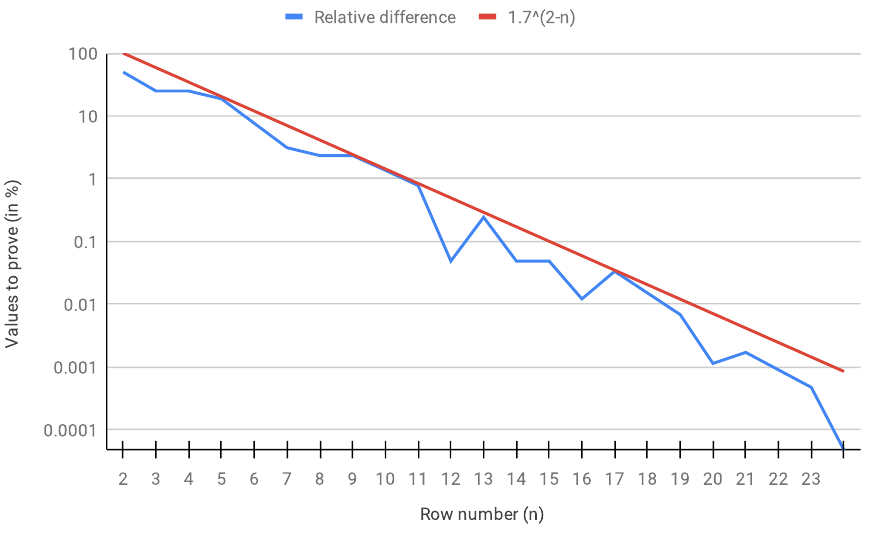
Figure 15. Log scale of the proportion (in %) of presumed unproven numbers in each row n + 1 when row n is finished by Golden Automaton II. The line of 1.7 ( 2 − n ) is shown in red for comparison. Averaged across pairs of successive rows, the amount of presumed unproven numbers in every row n + 1 when row n had been proven to exhibit a linear tendency (see Figure 16).